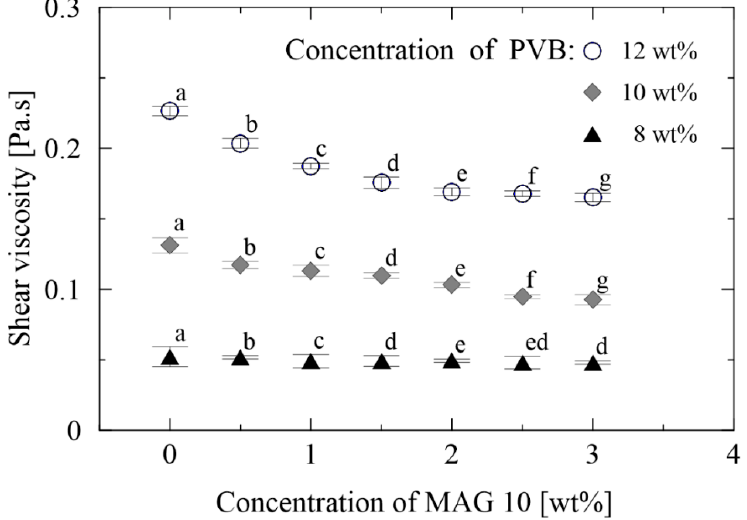
Figure 2. Shear viscosity of the neat PVB and PVB / MAG 10 solutions. The various letters indicate significant di ff erences ( p < 0.05) between the samples.